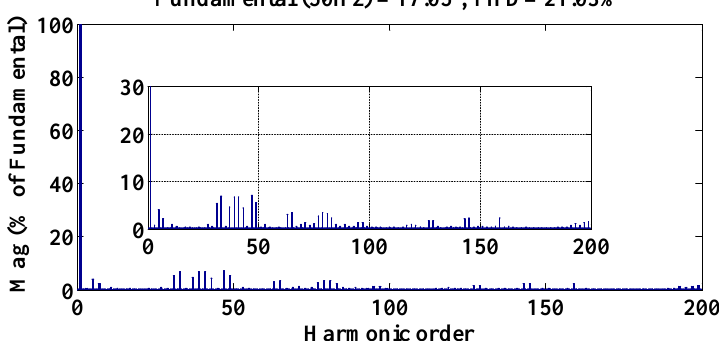
Figure 10. FFT plot for the output voltage of the APODPWM strategy.